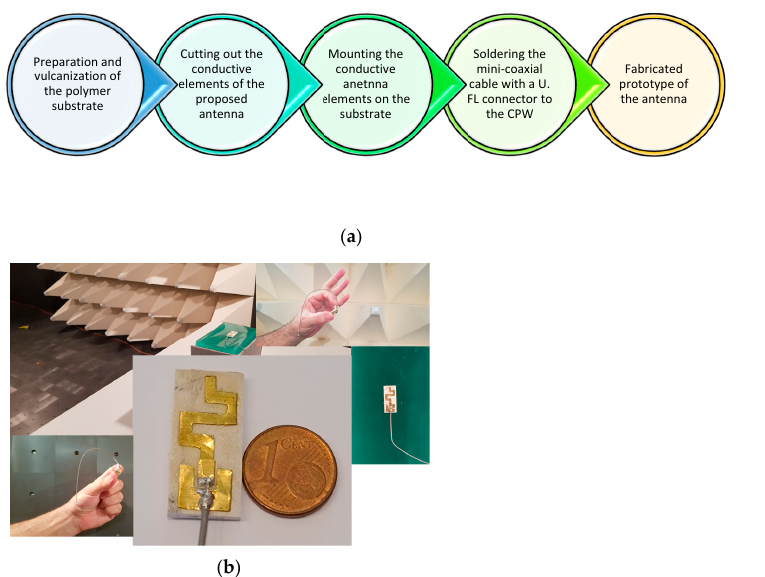
Figure 7. Fabrication process: ( a ) block diagram and ( b ) photographs of the fabricated antenna and experimental flat semisolid 2/3 muscle phantom.